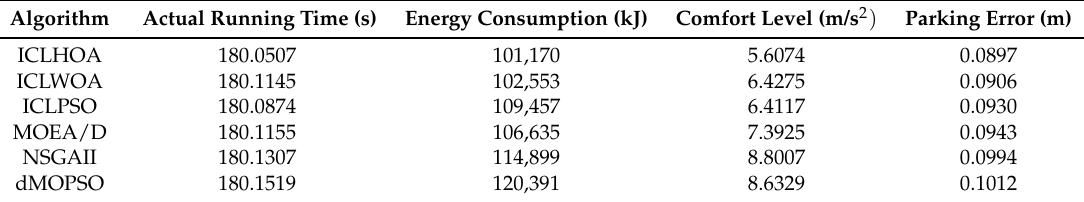
Table 5. Optimization results of velocity ideal trajectory profile obtained by different algorithms in isolating ‘control loop’ containing physical hardware devices (ICL)-hardware-in-the-loop simulation (HILS).